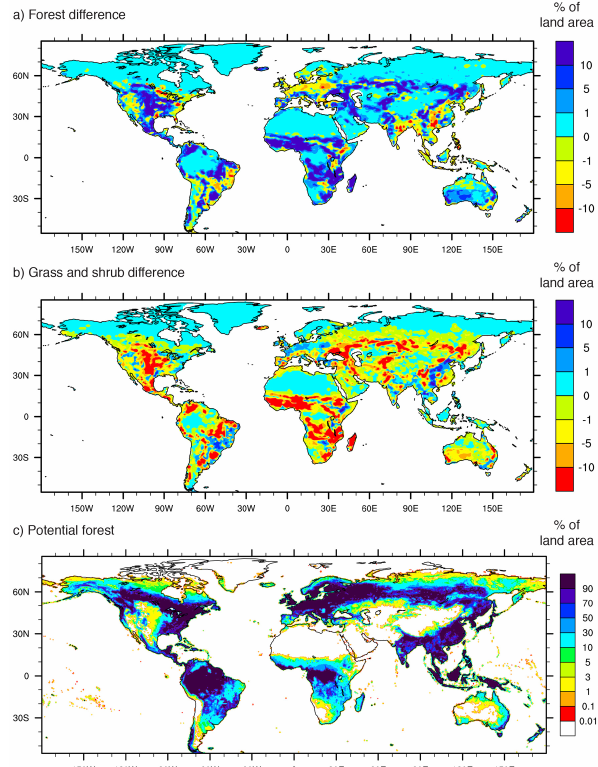
Figure 8. Spatial distributions of iESM increased forest PFTs, de- creased grass and shrub PFTs, and potential forest PFTs, as percent- ages of land area within each grid cell. (a) Difference in 2040 forest PFT area (NEWLUT–OLDLUT). (b) Difference in 2040 grass plus shrub PFT area (NEWLUT–OLDLUT). (c) Potential forest PFT